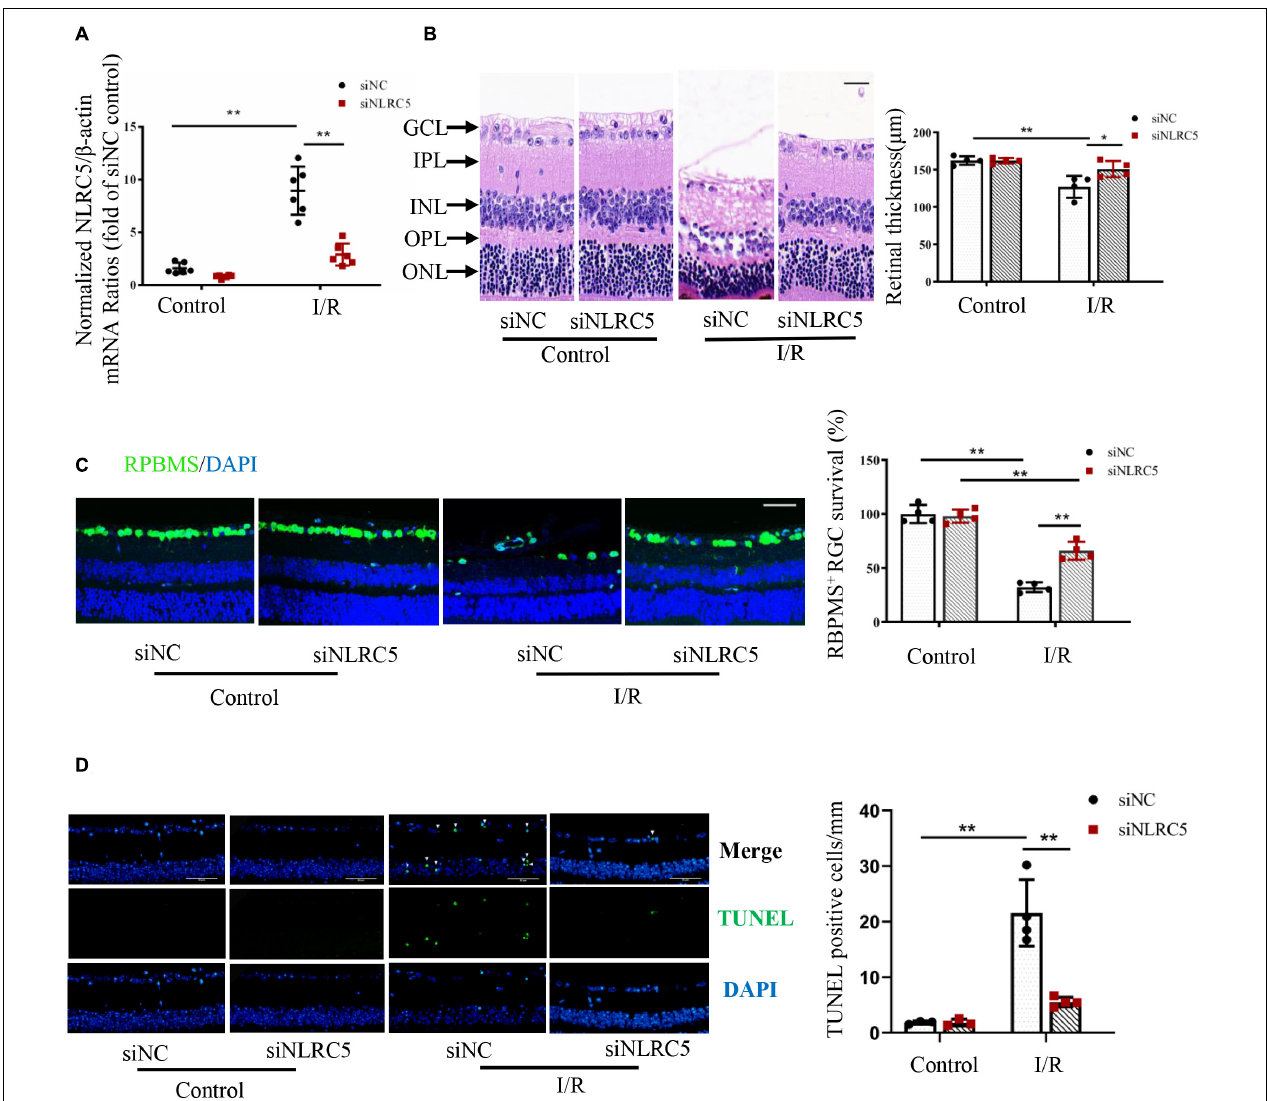
FIGURE 2 | NLRC5 knockdown effectively ameliorates retinal damage following ischemia–reperfusion. (A) RT-qPCR analysis of retinal NLRC5 gene knockdown efficiency using a targeted siRNA ( n = 6). (B) HE staining of mouse retina showing that intravitreal injection of NLRC5 siRNA ameliorates tissue damage and reverses the reduction in retinal thickness following ischemia–reperfusion compared to retinas transfected with control siRNA (Scale bar: 30 µ m, Magnification: × 400, n = 4). (C) Retinal immunofluorescence images and corresponding quantitative analysis of anti-RBPMS-labeled RGCs showing that the reduction in RGC number following RIR is reversed by NLRC5 knockdown (Scale bar: 50 µ m, Magnification: × 200, n = 4). (D) TUNEL staining of retina following RIR (Scale bar: 50 µ m, Magnification: × 400, n = 4). The white arrow indicates TUNEL-positive cells. All samples were obtained on the third day of reperfusion. I/R, retinal ischemia–reperfusion; ONL, outer nuclear layer; OPL, outer plexiform layer; INL, inner nuclear layer; IPL, inner plexiform layer; GCL, ganglion cell layer. Results are presented as mean ± SD. * P < 0.05, ** P < 0.01. Two-way ANOVA with post hoc Bonferroni tests was applied.